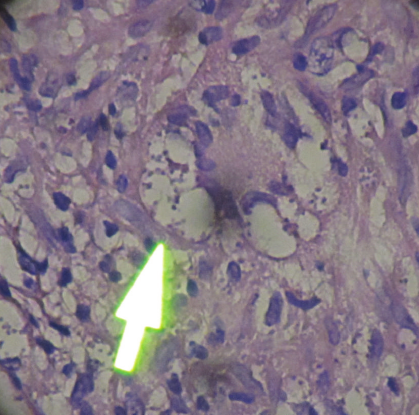
Figure 3: Leishman body in H&E staining slide of the